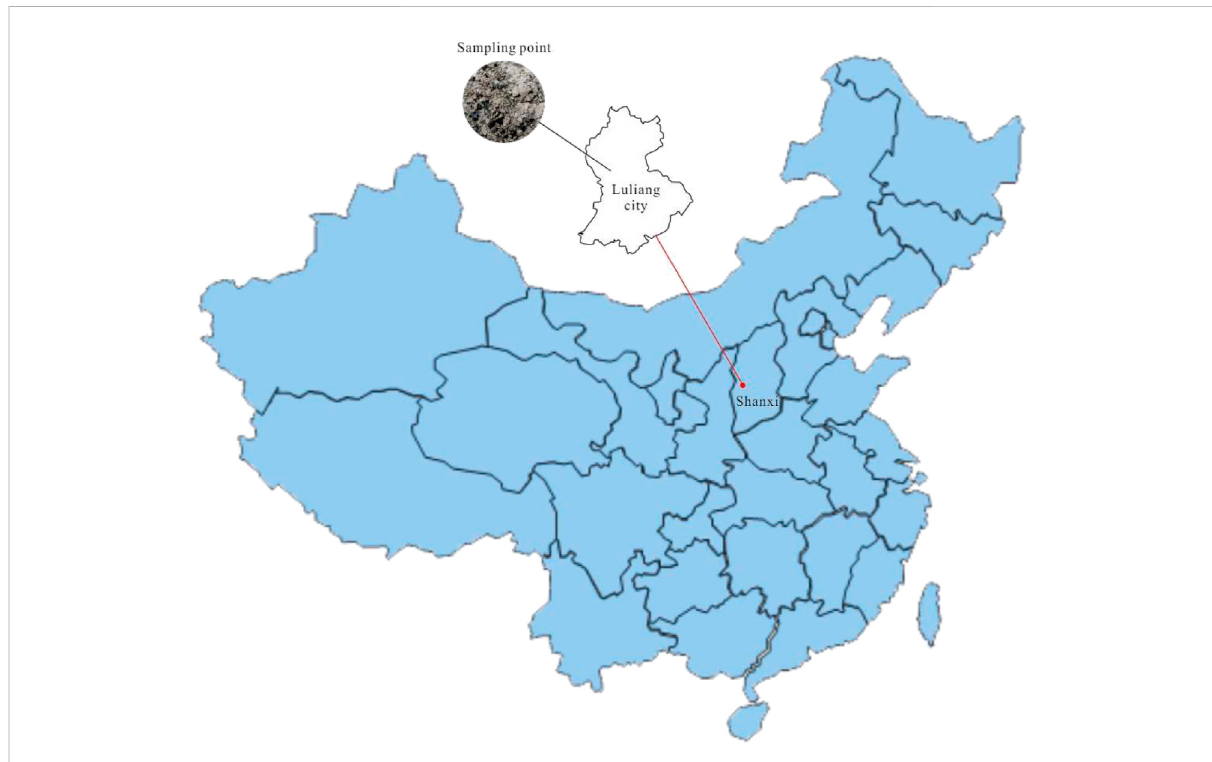
FIGURE 1 Location of the sampling